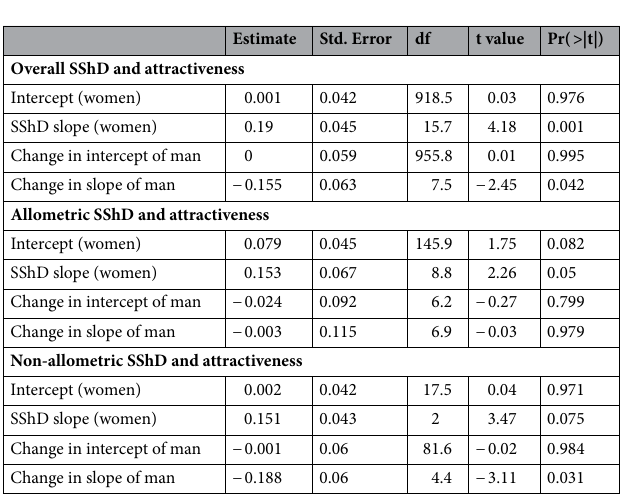
Estimate Std. Error